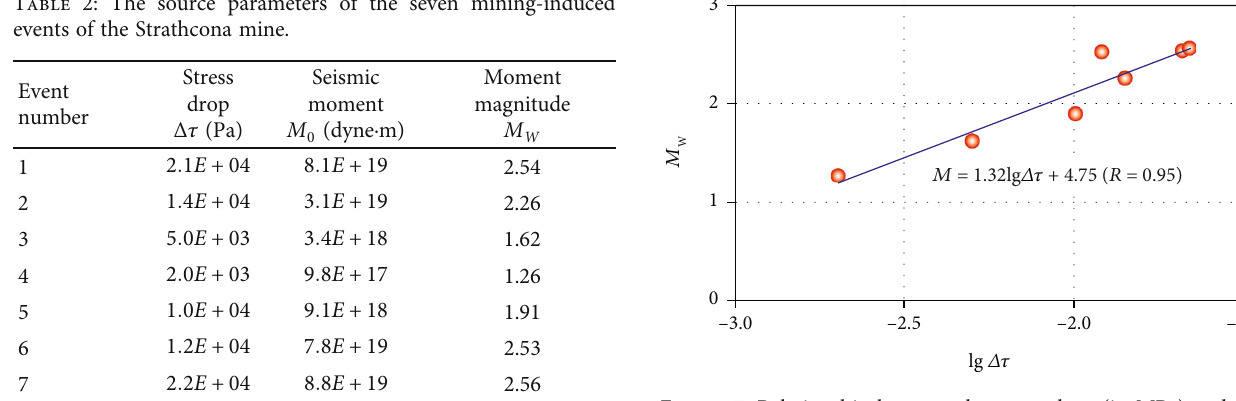
Figure 7: Relationship between the stress drop (in MPa) and the earthquake magnitude. Red dots represent seven events triggered by mining activity at the Strathcona